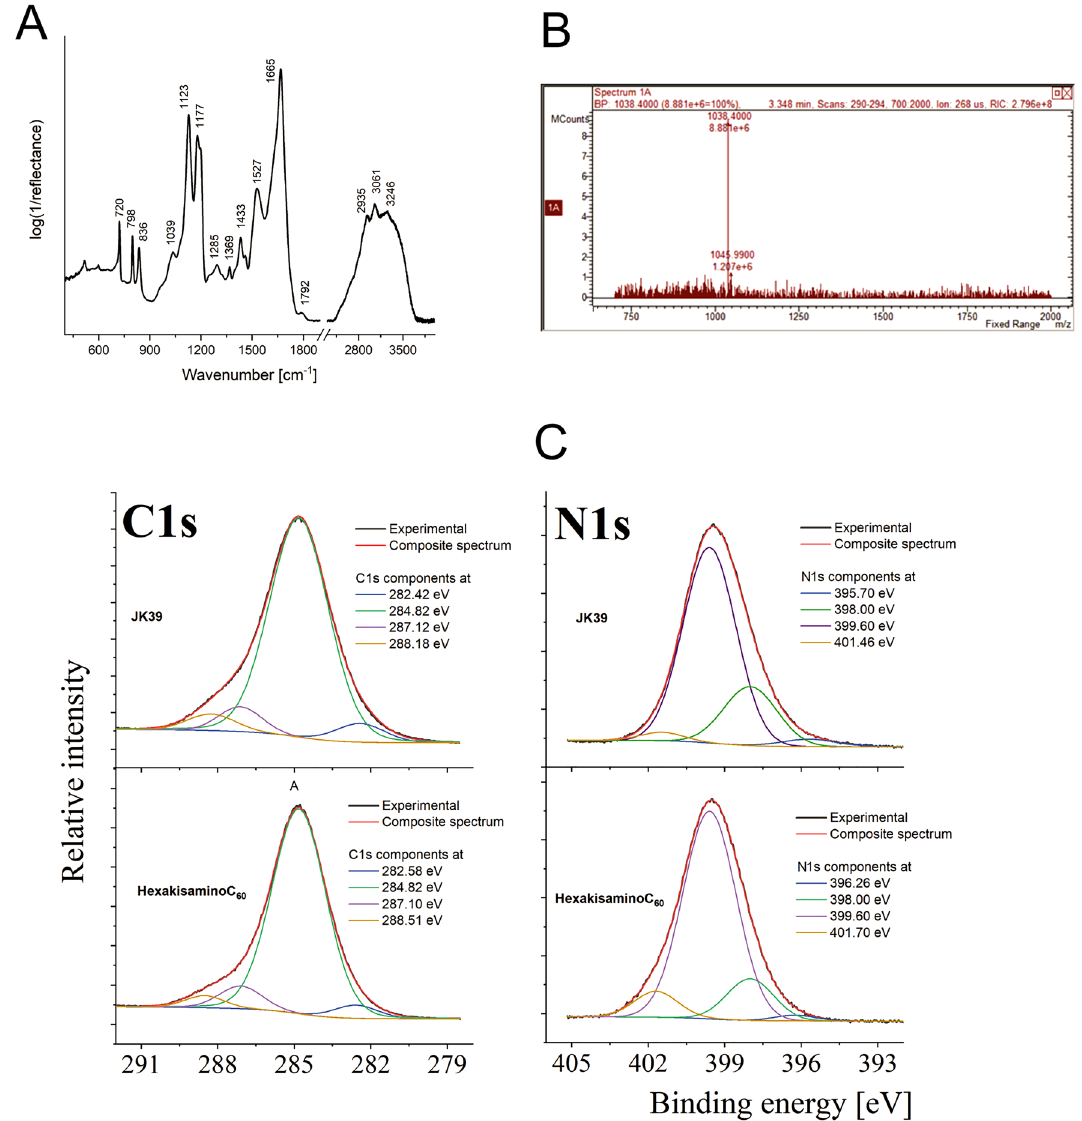
fullerene nanomaterials JK39 and HexakisaminoC 60